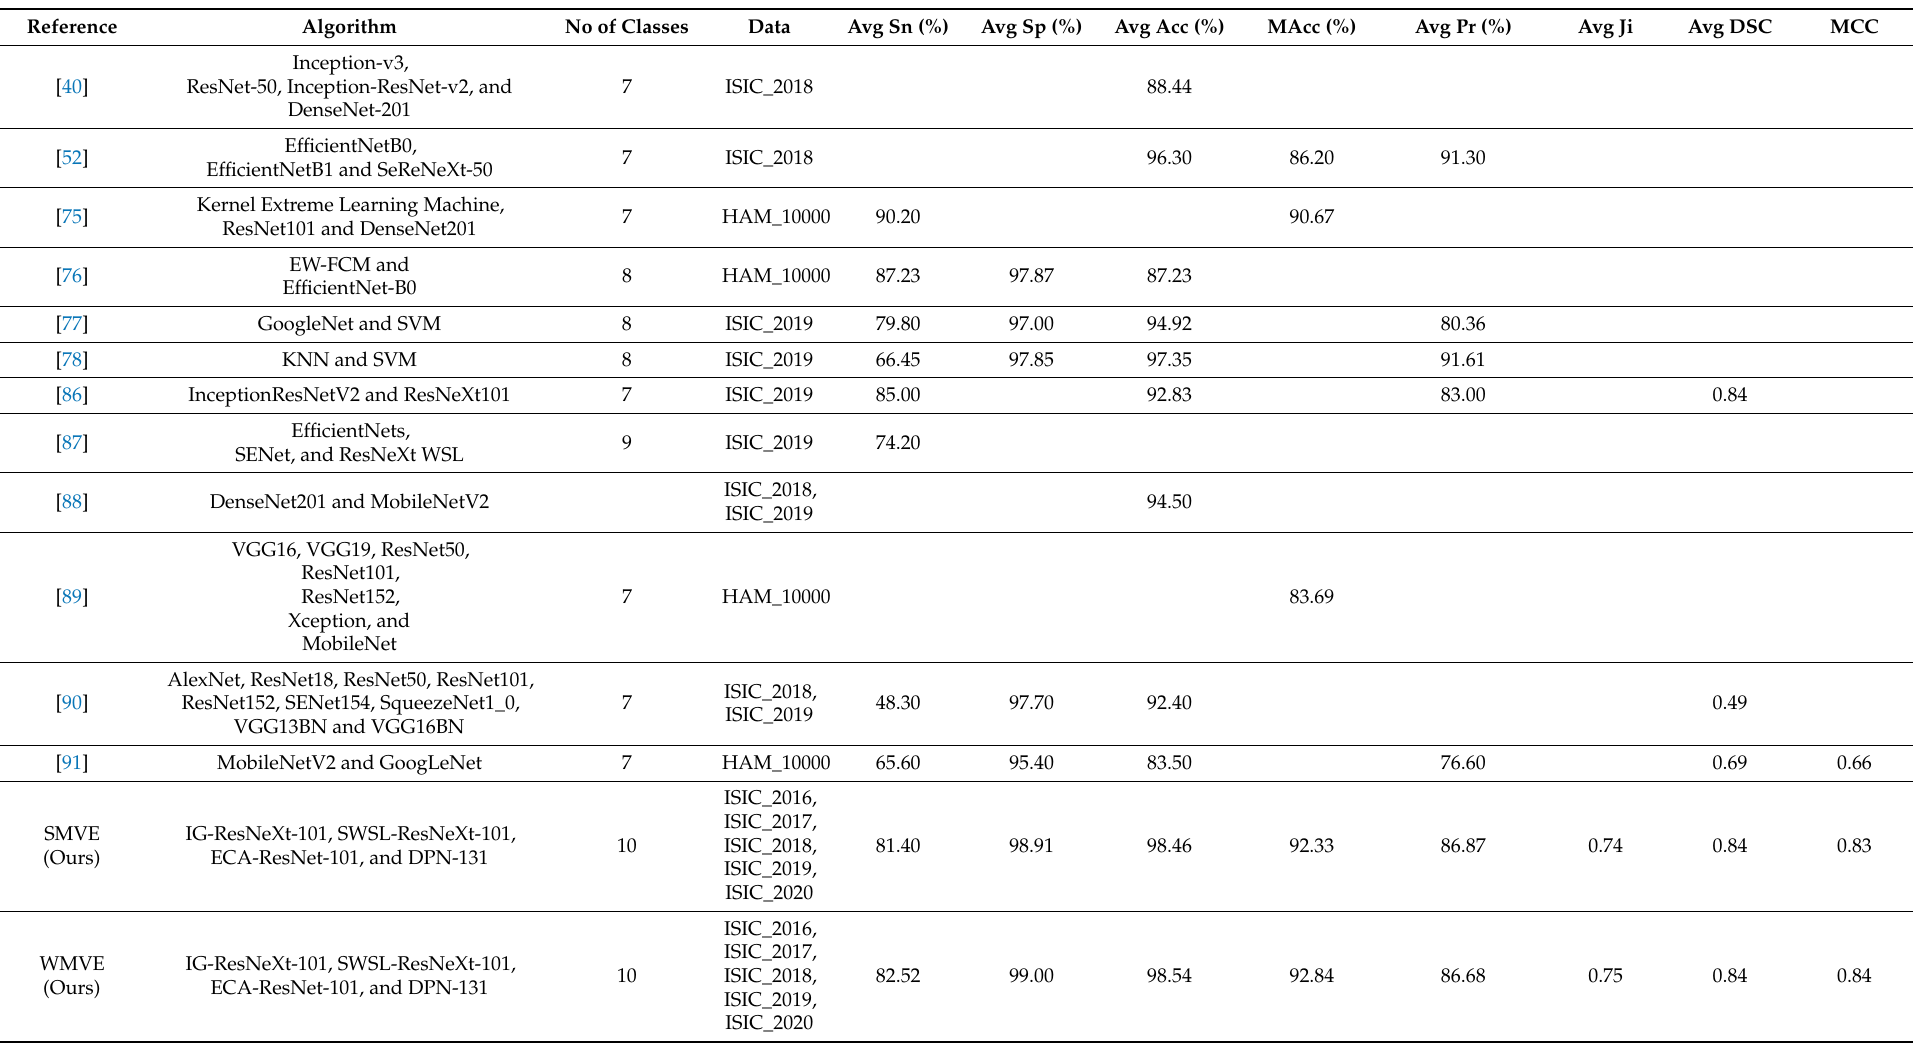
Table 7. Algorithm comparison with the state-of-the-art ensemble learning